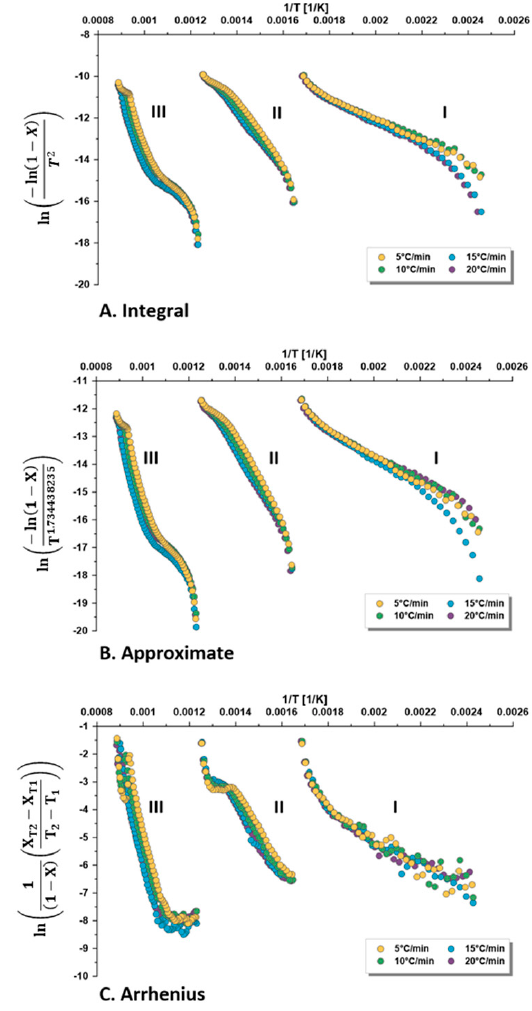
Figure 5. Kinetic analysis of TGA data of the three decomposition zones of oil shale (I. drying, II. pyrolysis, III. mineral decomposition) using three kinetic methods: ( A ) integral; ( B ) approximate temperature integral; and ( C ) direct Arrhenius, at different heating rates ( β ) of 5, 10, 15 and 20 °C/min.